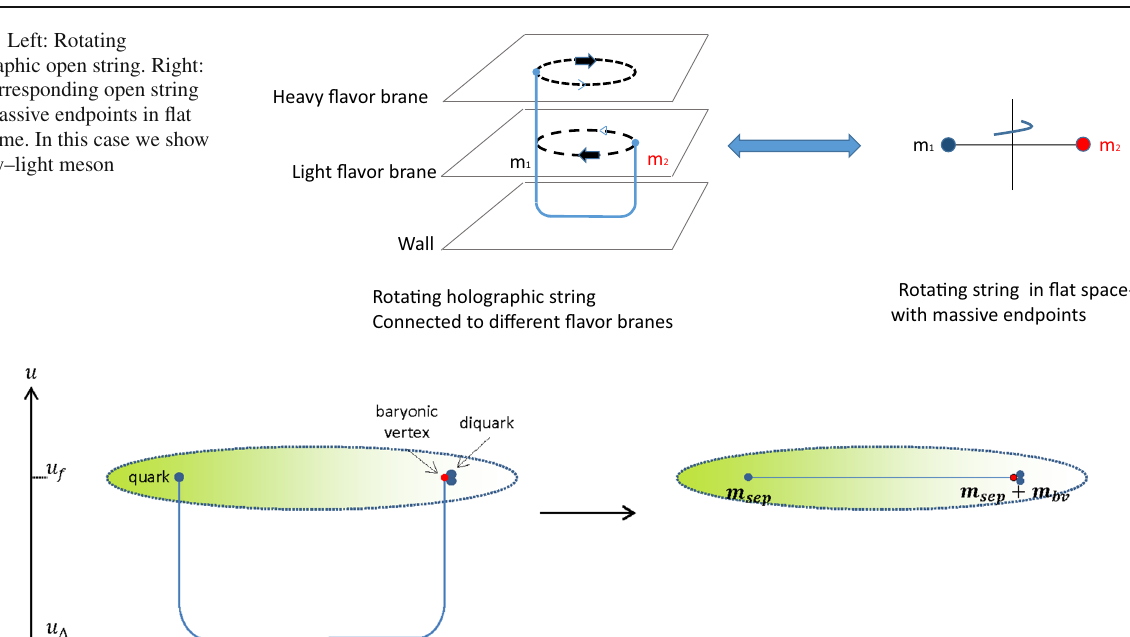
Fig. 2 The holographic setup (for N c = 3) of a quark and a diquark is mapped to a similar configuration in flat spacetime. The vertical segments of the holographic string are mapped into masses of the endpoints. The mass of the baryonic vertex also contributes to the endpoint mass